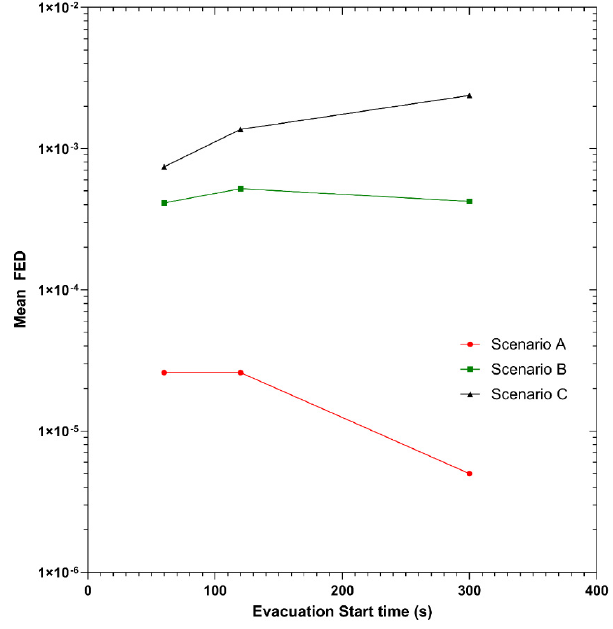
Figure 16. Mean FED index for the three different scenarios and evacuation times.